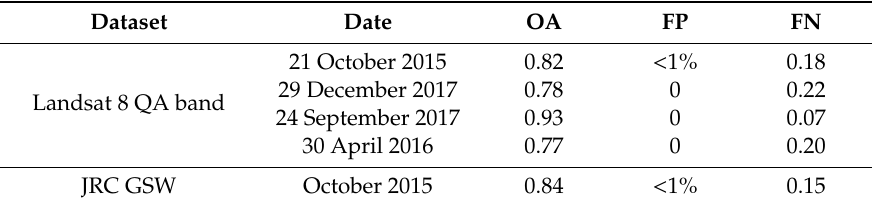
Table 4. Accuracy results for global datasets.